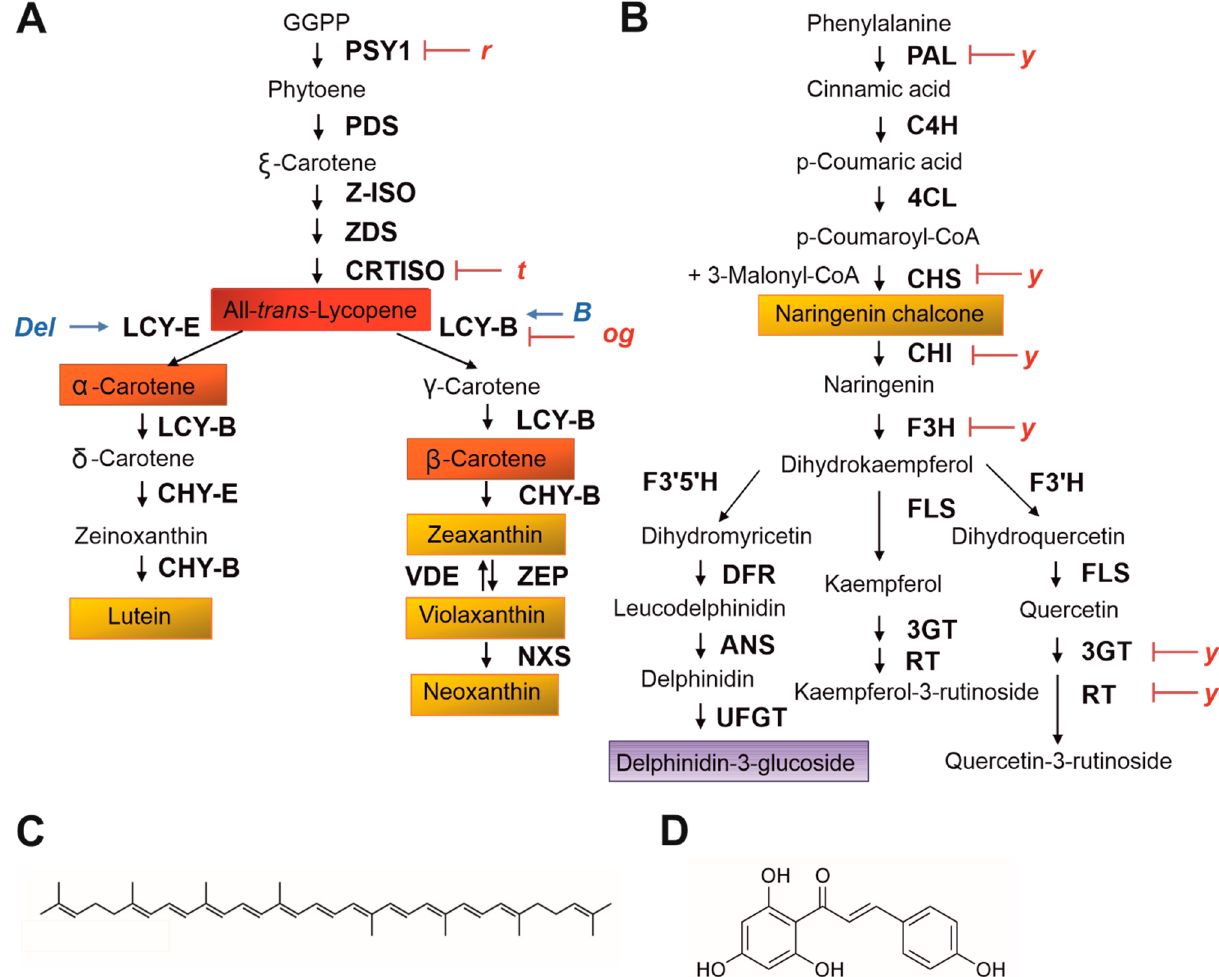
Figure 1. ( A ) The carotenoid biosynthetic pathway in tomato fruit. GGPP, geranylgeranyl diphosphate; PSY1,